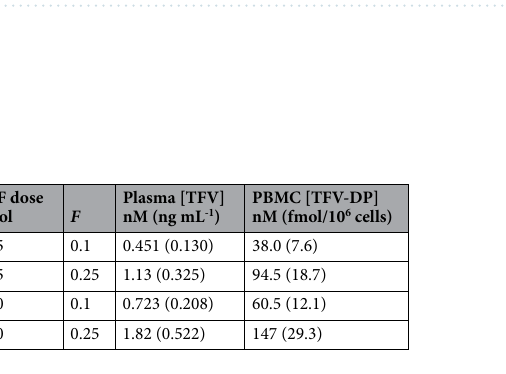
Table 5. Simulated systemic drug concentrations in C57BL/6 J mice at 6 h following oral TAF dosing over a range of oral bioavailabilities ( F